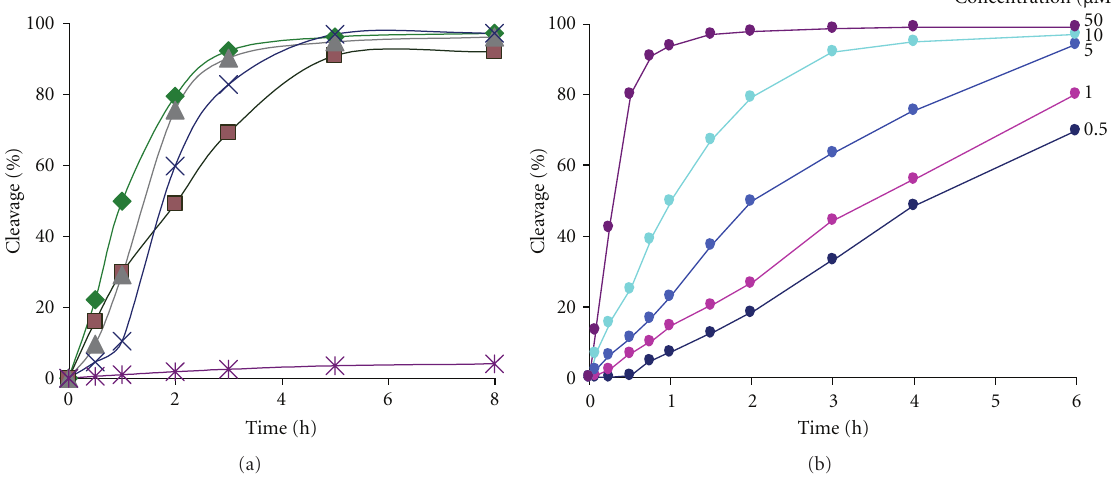
Figure 3: Kinetics of tRNA Phe cleavage by the conjugates: (a) tRNA cleavage by B-Im(4/1) ( 3 ) (rhombs), B-Im(4/2a) ( 4a ) (squares), B-Im(4/3) ( 5 ), (asterisks), B-Im(8/4+1) ( 10 ) (triangles), and B-Im(24/4+2) ( 12 ) (crosses) under standard conditions at conjugates concentration 10 μ M. (b) tRNA cleavage by B-Im(4/1) ( 3 ) at concentrations ranging from 0.5 to 50 μ